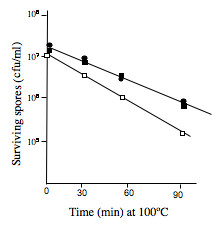
Thermal death curves for sporulating cultures of wild-type SM101 (●), ssp3 mutant DR101 (□), and complemented DR101(pDR18) (■) strains. The data is the result of a representative experiment; these results were highly reproducible (data not shown).